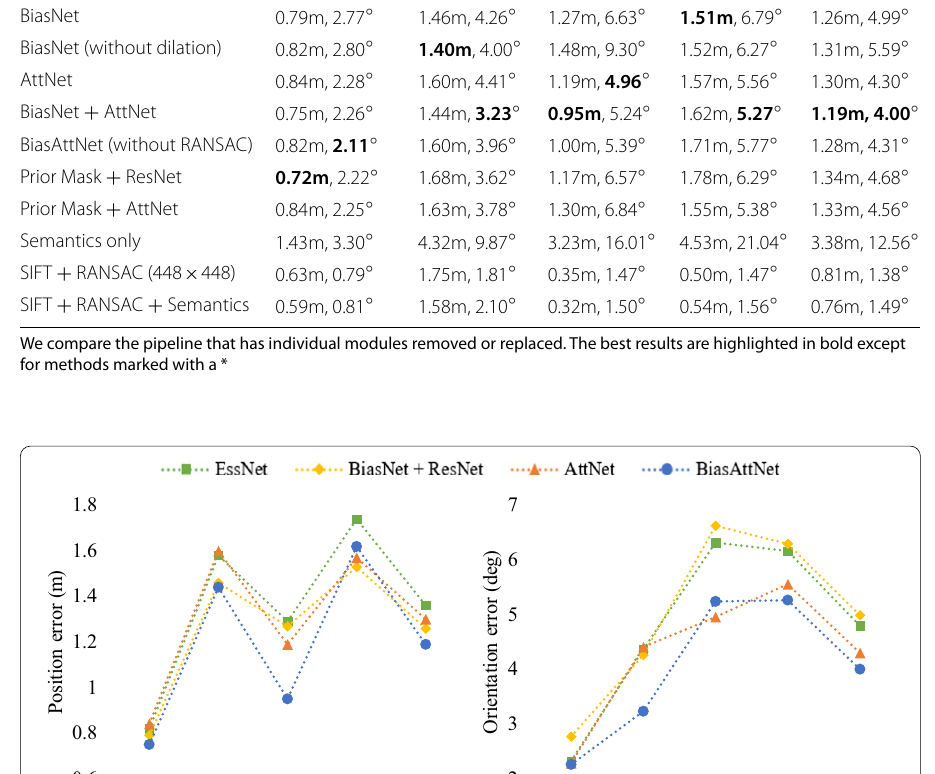
Table 3 Results of ablation study